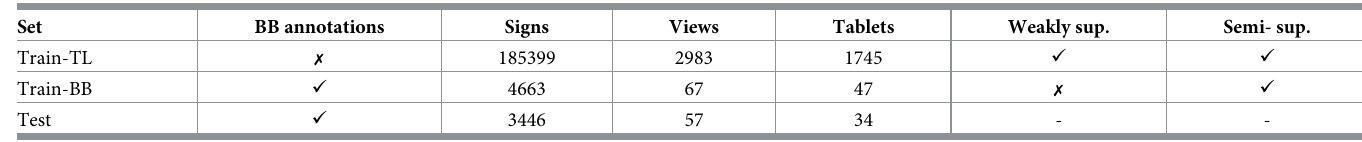
Table 1. Composition of the two train sets and the test